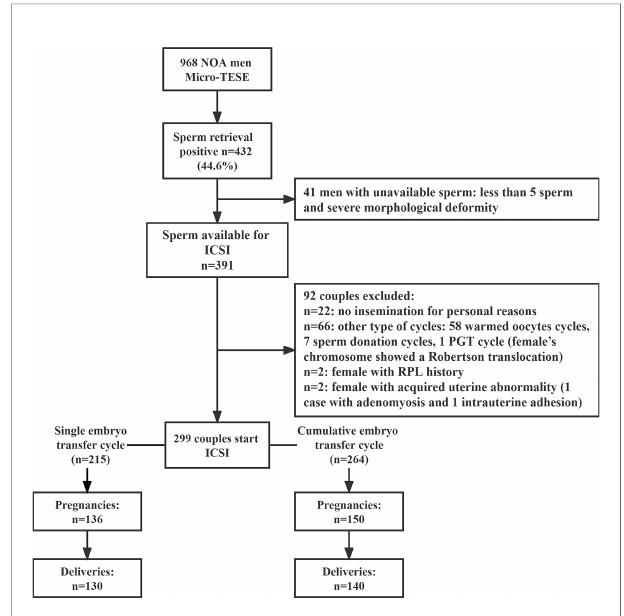
FIGURE 1 | Schematic overview of the